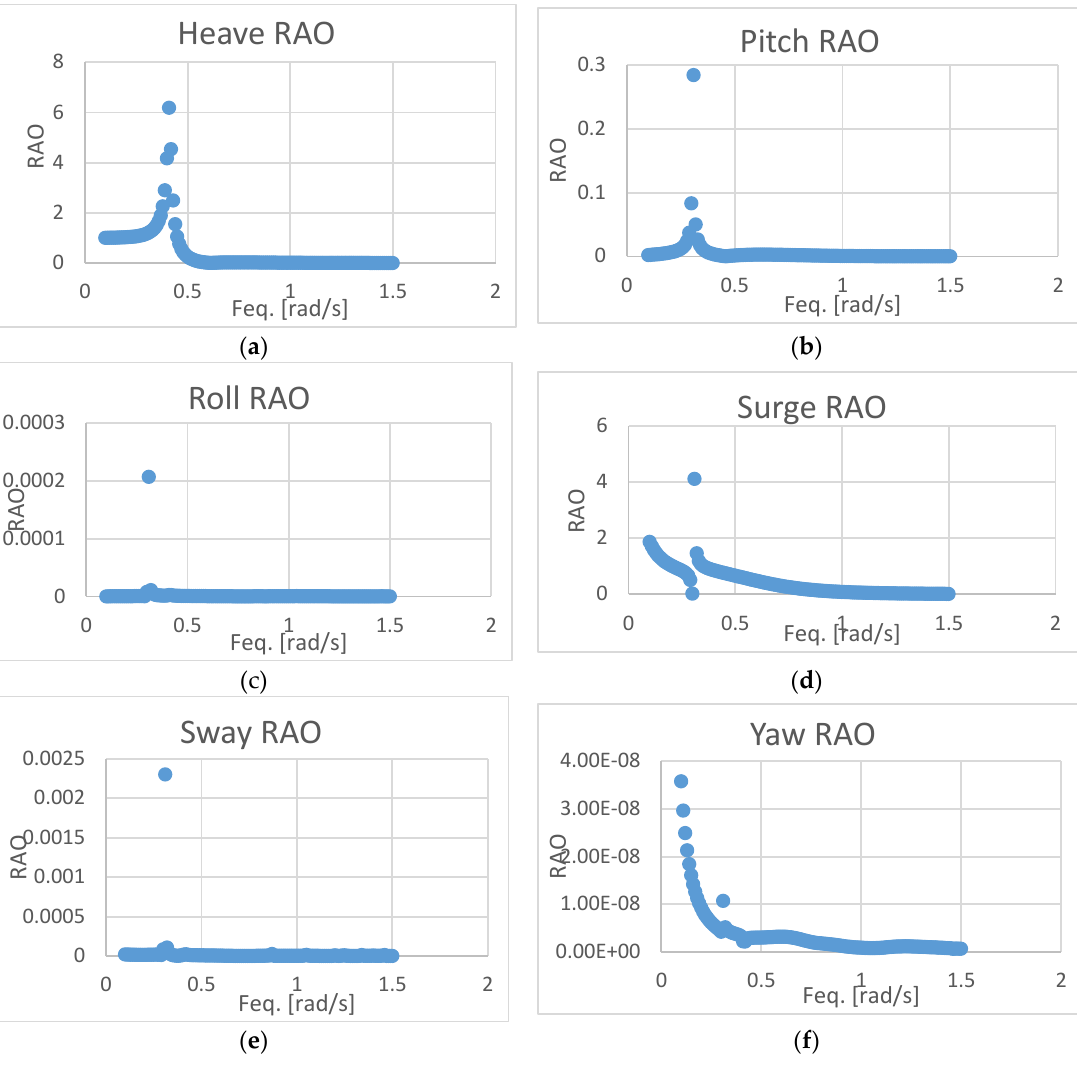
Figure 18. The motion response at six degrees of freedom for the FDP concept. ( a ) Heave RAO; ( b ) Pitch RAO; ( c ) Roll RAO; ( d ) Surge RAO; ( e ) Sway RAO; ( f ) Yaw RAO.